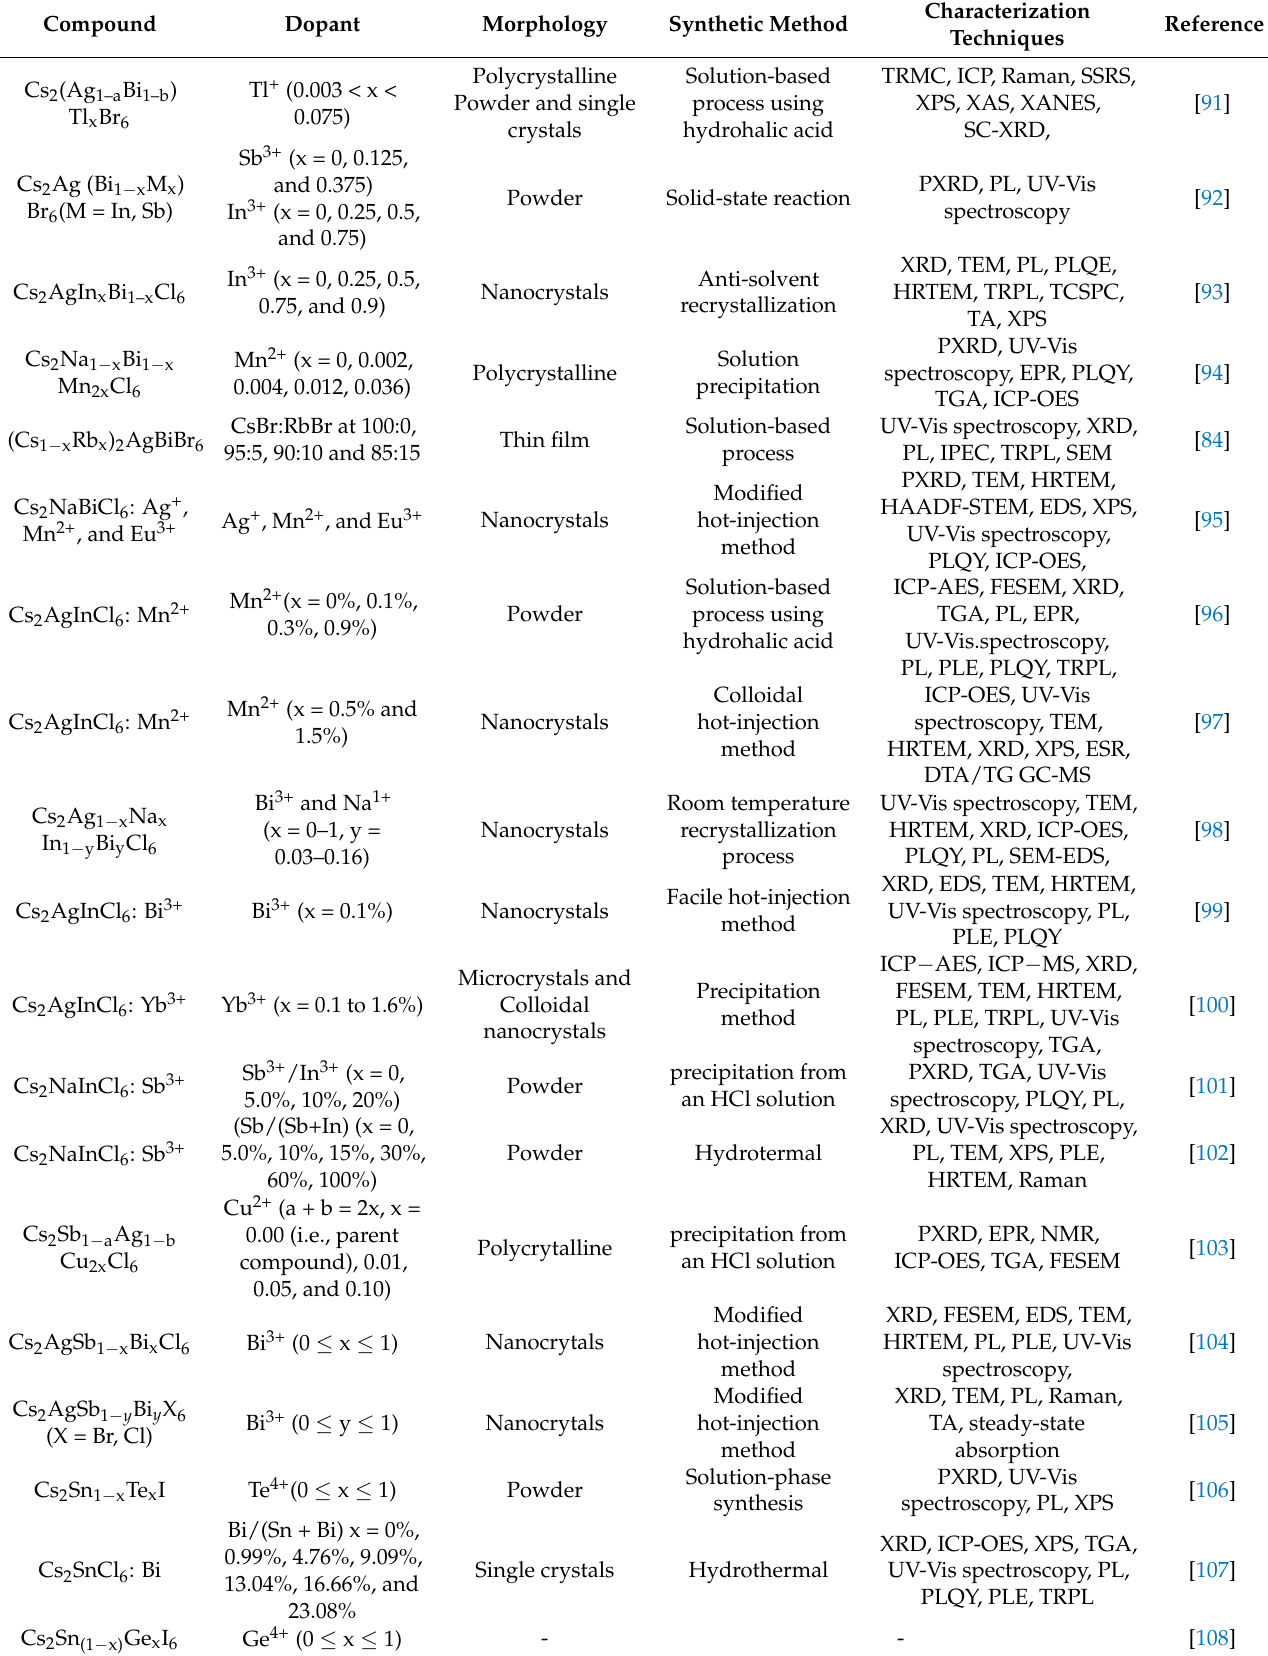
Table 3. Summary of prepared doped- Cs-based double halide perovskite